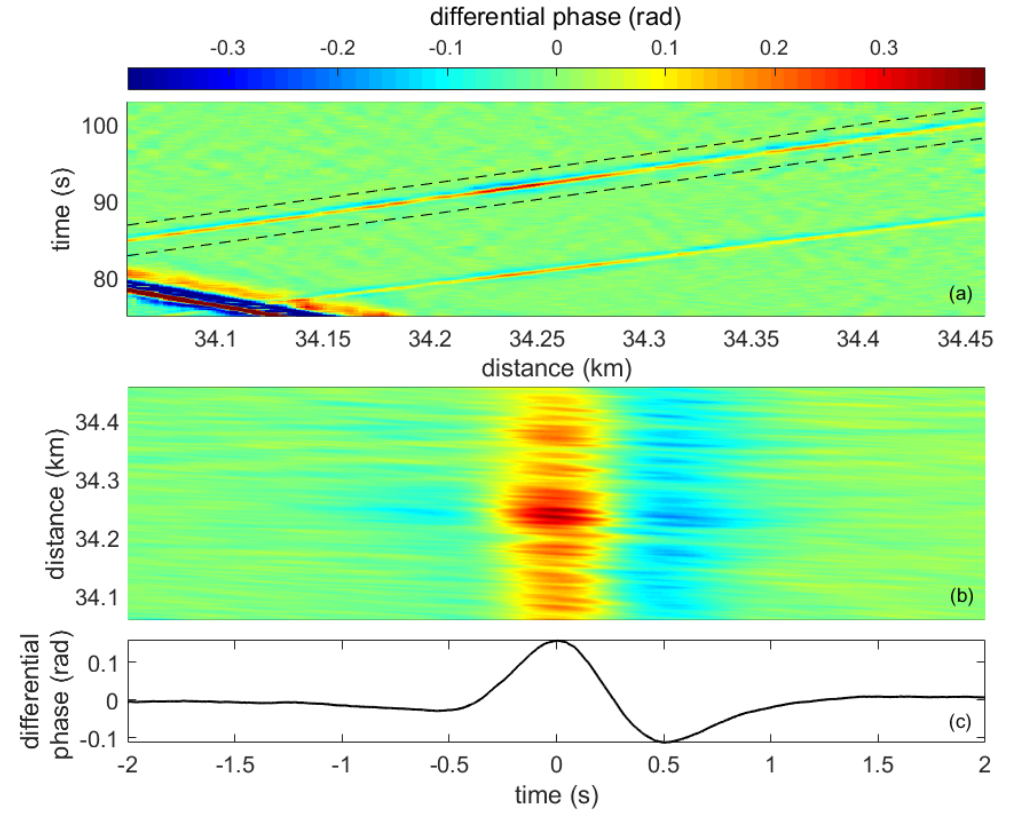
Figure 5. Vehicle passing event represented by: ( a ) the heat-map representing the differential phase measurements for a given time-distance window, where a vehicle signature signal trajectory can be identified, ( b ) a two-dimensional crop of the differential phase signal of ± 2 s around the trajectory; and ( c ) the vehicle signature trace, an averaged version of the former signal representing the vehicle signature in the time-axis.